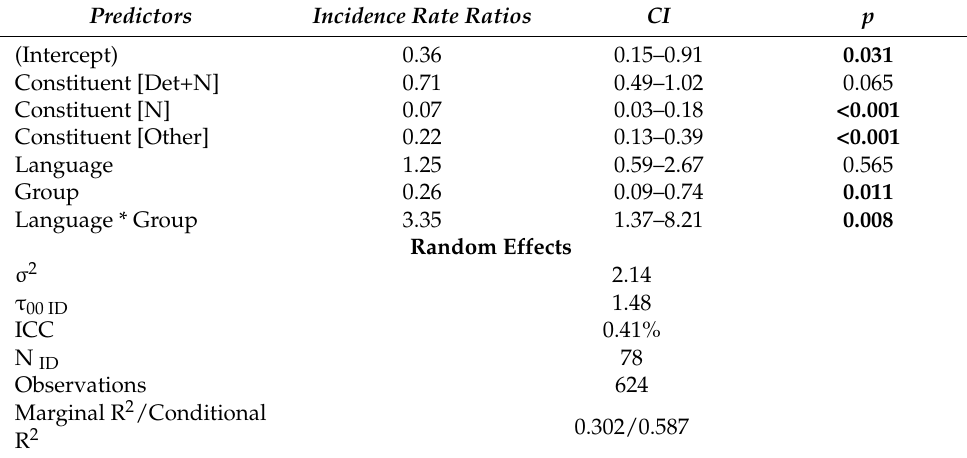
Table 7. Estimates of the model predicting the frequency of Non-targeted CS withing the Temporal